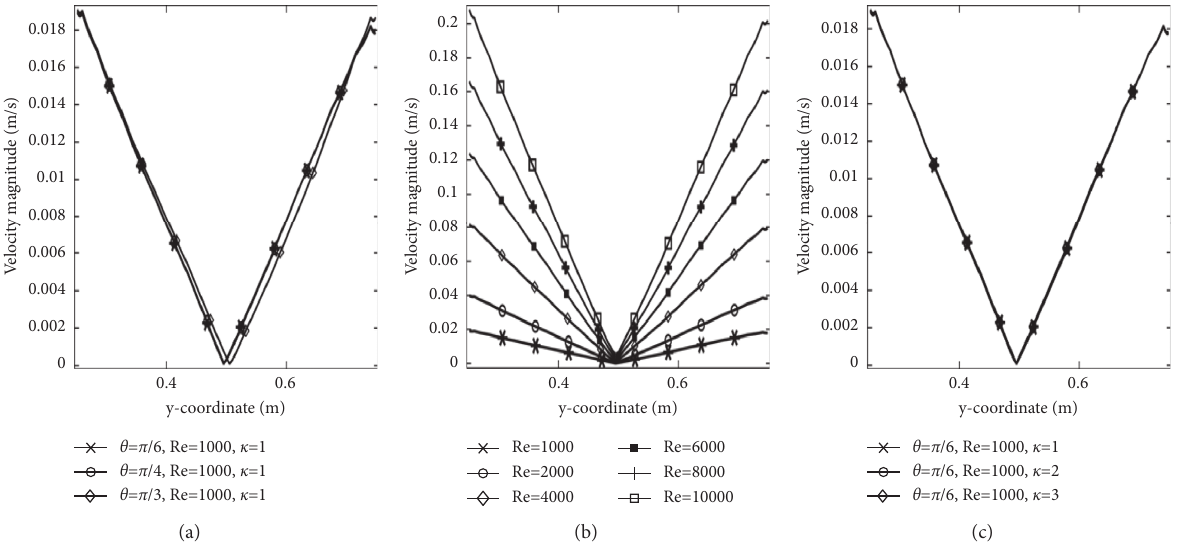
Figure 4: Pattern of the velocity magnitude (m/sec) on the front surface of the circular cylinder (a) for all angles by fixing Re � 1000 and κ � 1; (b) for all Re by fixing κ � 1 and θ � π /6; (c) for all κ by Re � 1000 and θ � π